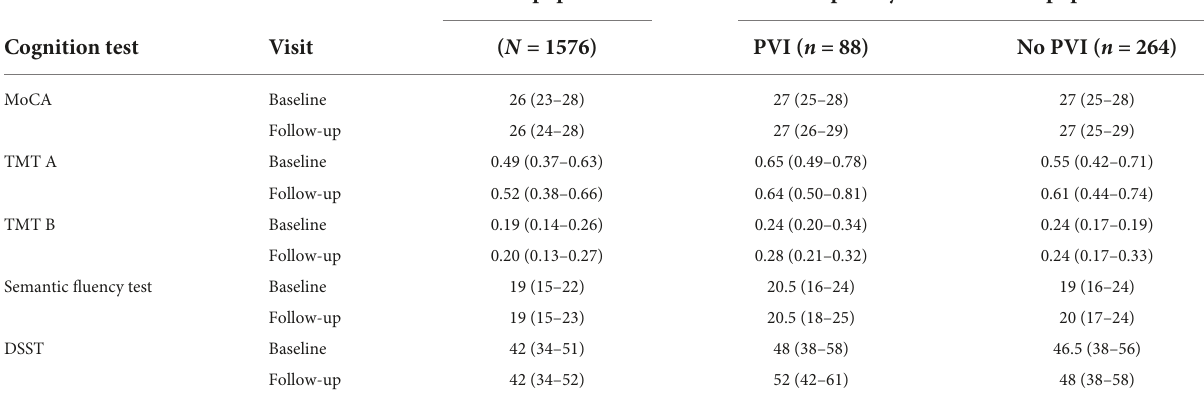
TABLE 2 Results of neuropsychological tests at baseline and